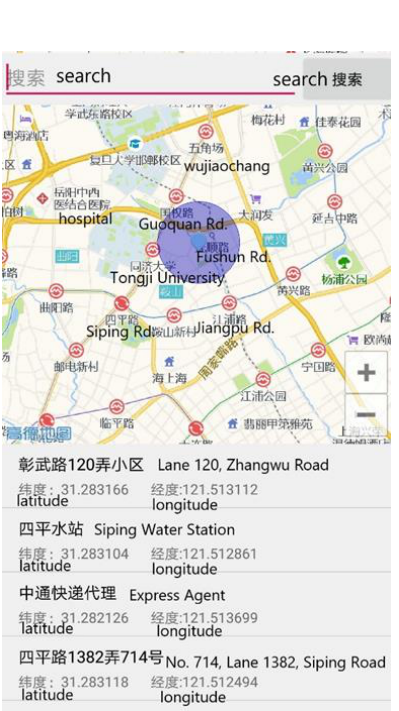
Figure 2. System framework